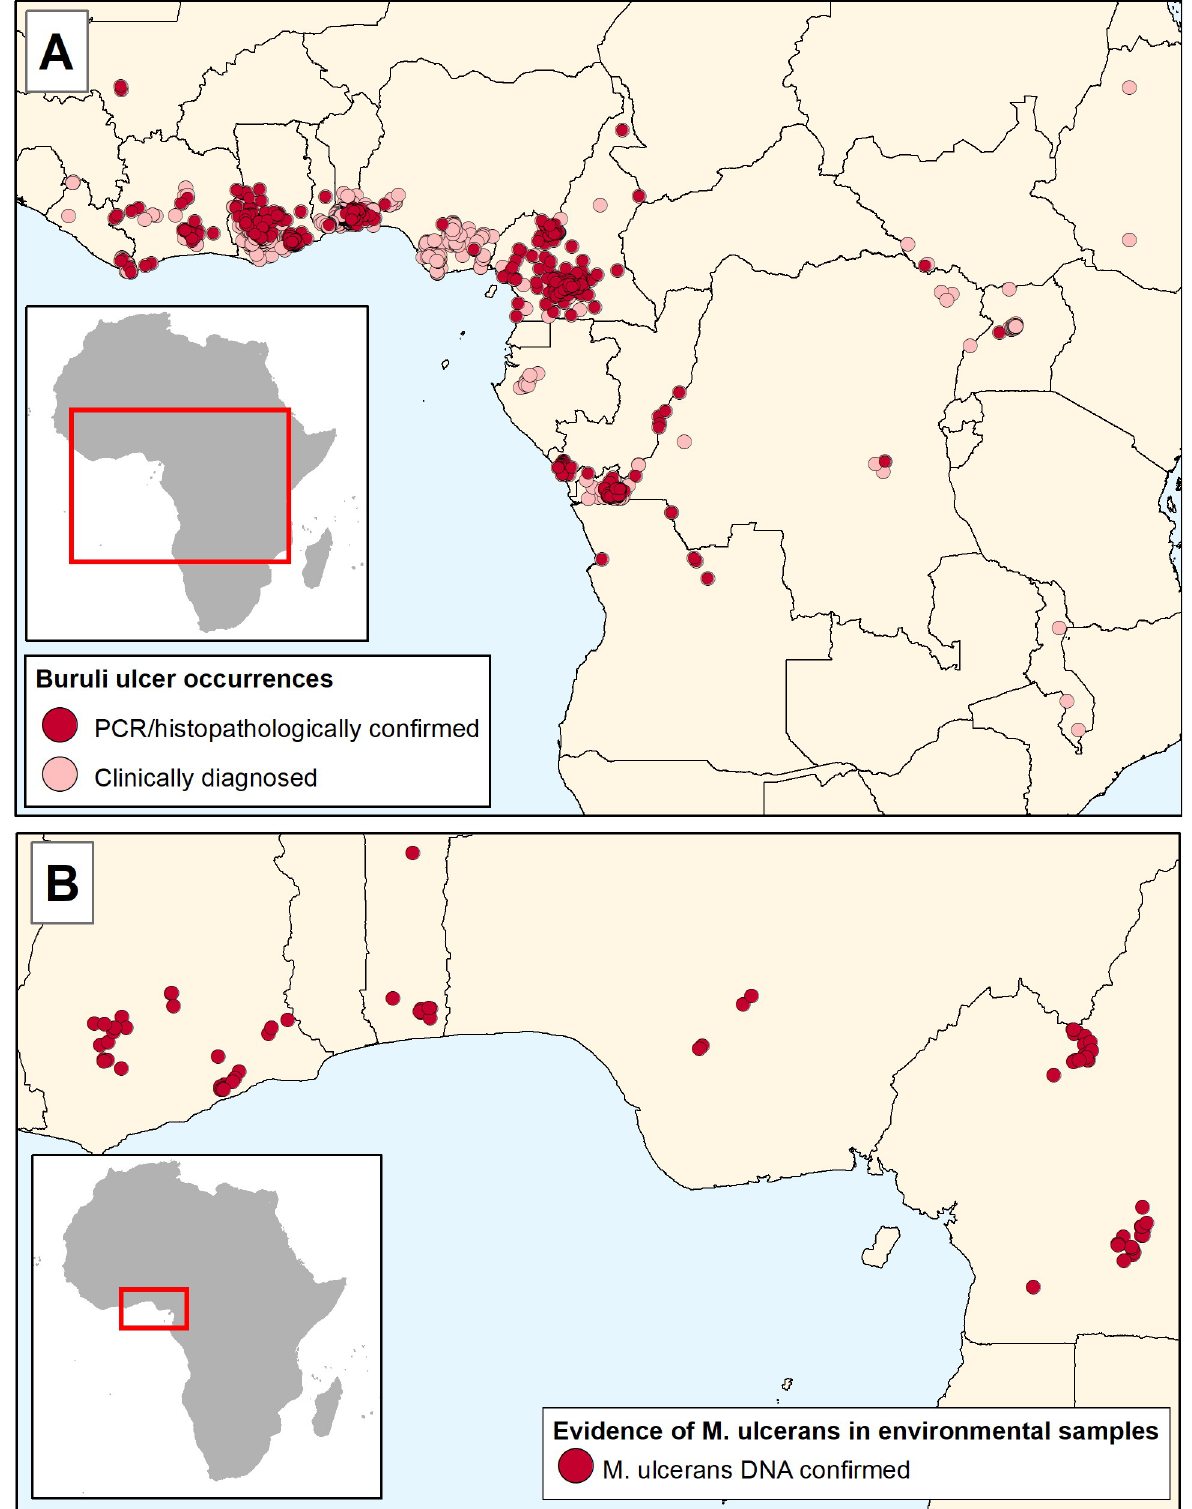
Fig 2. Distribution of occurrence records for environmental modelling of Burli ulcer (BU) and Mycobacterium ulcerans (MU) (A) Pink dots represent origins of clinically-diagnosed BU cases, red dots represent confirmed cases. (B) Red dots show locations where M . ulcerans DNA